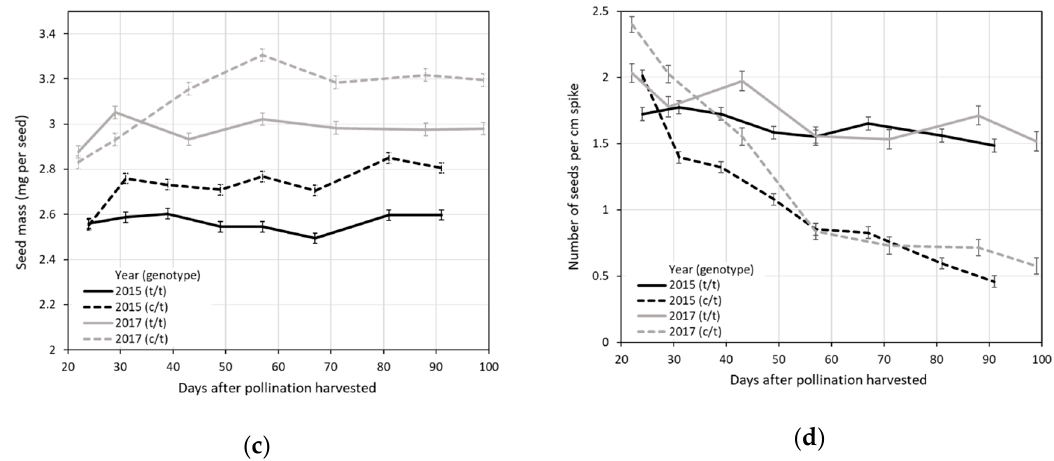
Figure 1. Comparisons of trait averages between heterozygous (c/t) and homozygous (t/t) genotypes of the L. cinereus (c) and L. triticoides (t) Ltc096 marker alleles over eight different harvest dates in 2015 and seven different harvest dates in 2017, numbered days after pollination, for ( a ) seed yield per spike; ( b ) spike length; ( c ) seed mass; and ( d ) seed density.